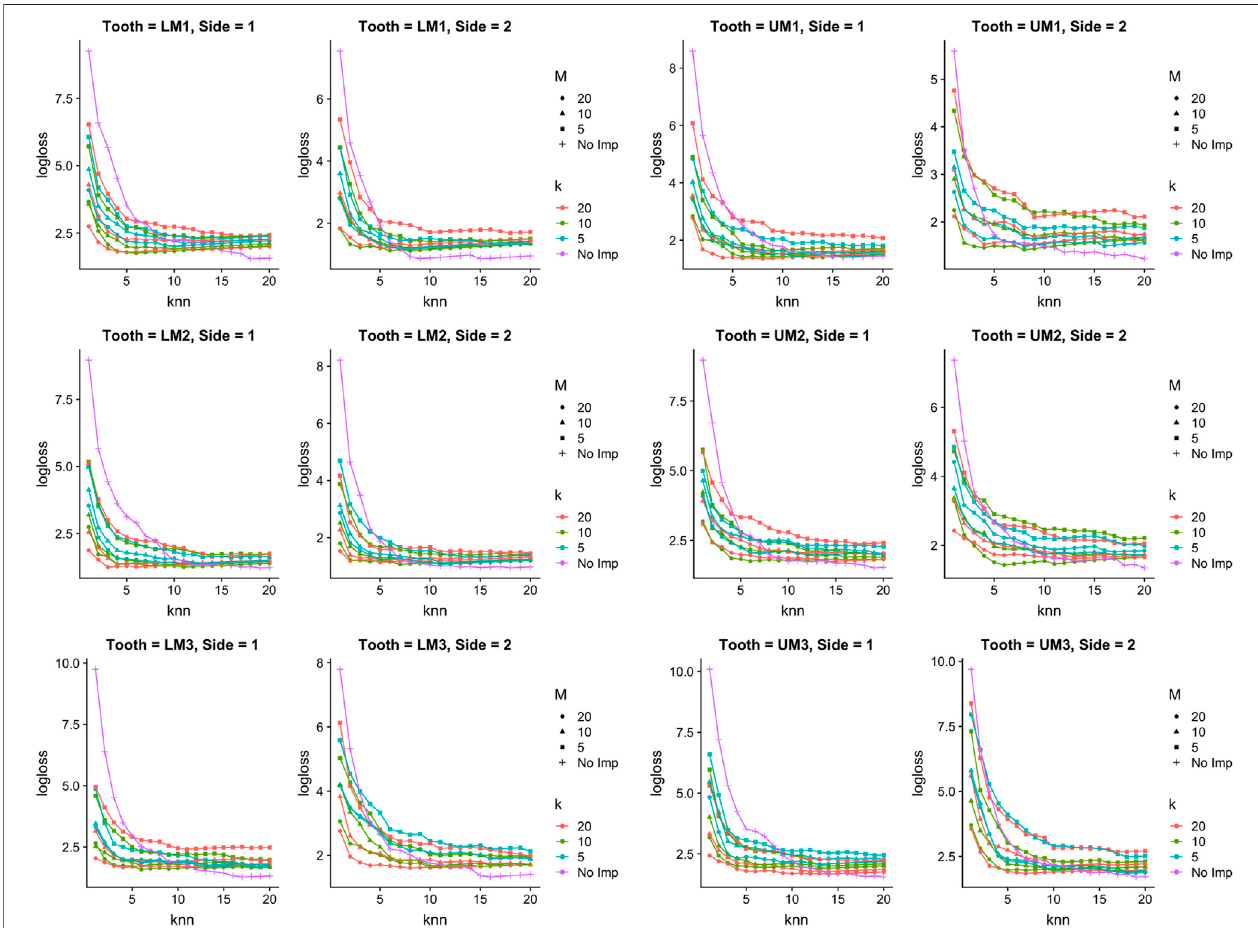
FIGURE6| Speciesclassi fi cationinsimulatedsetting .Log-lossfortheknn-impclassi fi erasafunctionofnumber k n neighborsfordifferentvaluesofdonorsetsize K and number of imputations M ; purple “ No-imp ” curve represents the same for the knn classi fi er.